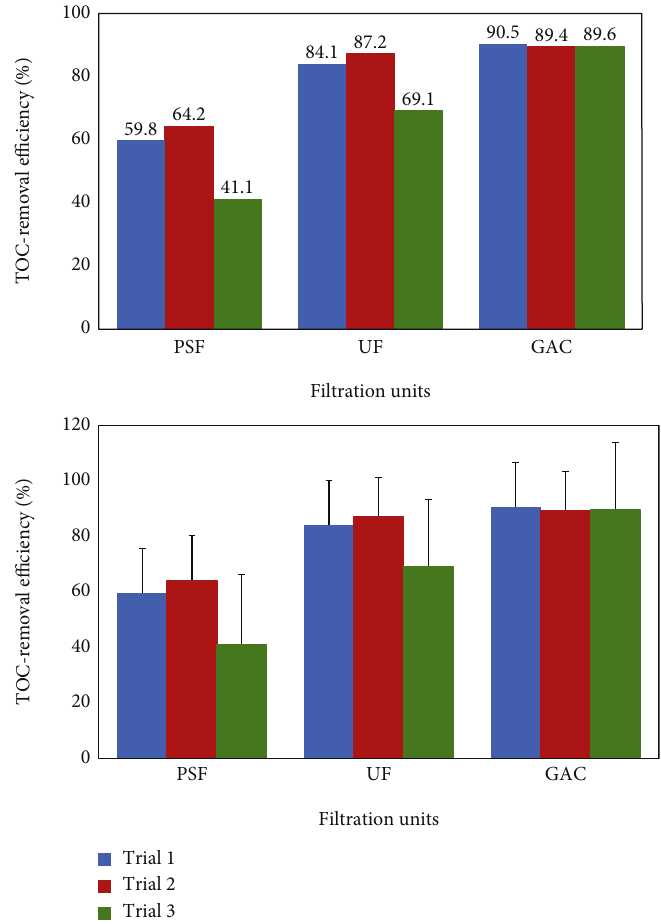
Figure 12: Bar chart representing the removal e ffi ciency of pollutants in PSF, UF, and